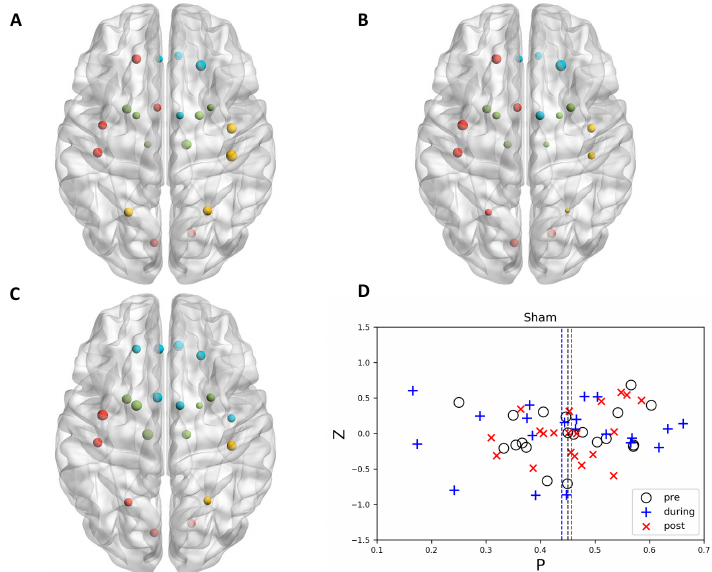
Figure 2. The node topology and community structure of sham stimulation in motor-related regions at ( A ) pre, ( B ) during, and ( C ) post time points (drawn by BrainNet Viewer [38].). Left orientation represents left side of the brain. Node size was determined by local efficiency. The nodes with the same color belonged to the same community in each subplot. ( D ) illustrated P - z plot for sham stimulation and the dashed line represents the mean P value for each time point.